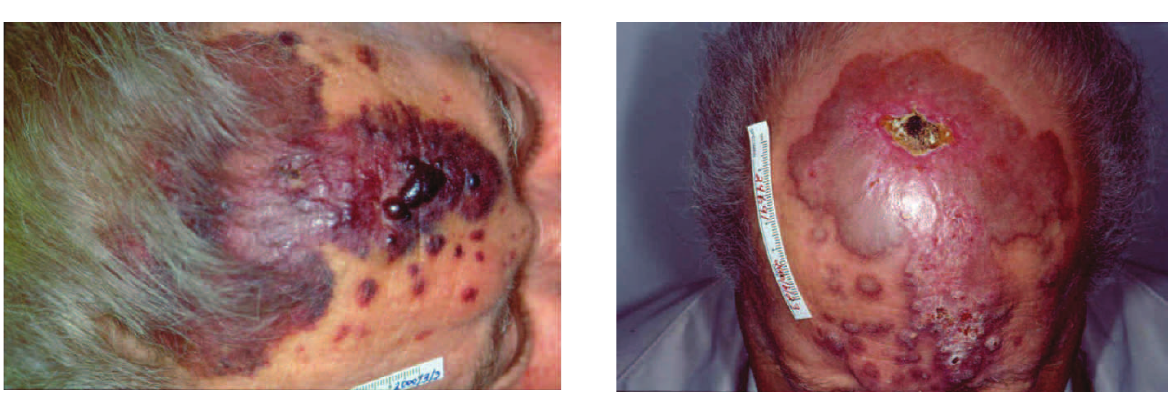
Figure 2. Progression of cutaneous angiosarcoma following two cycles of Caelyx (cid:1) .